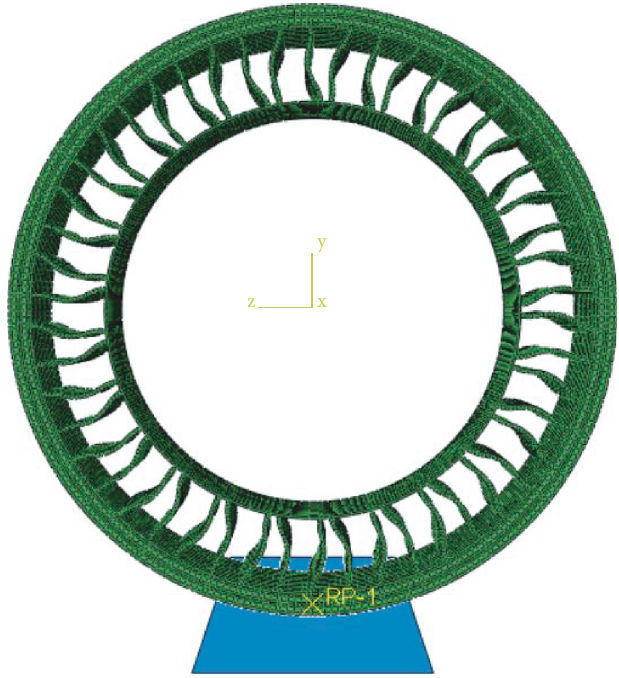
Figure 7: Finite element model.